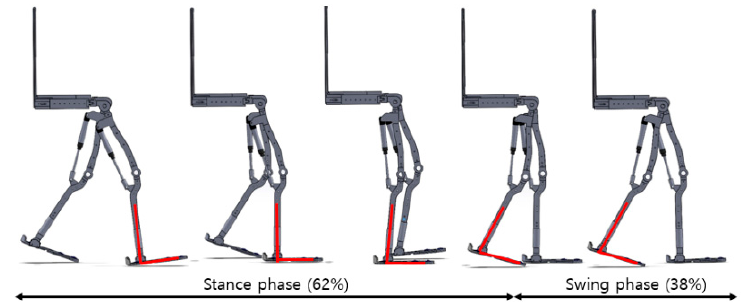
Figure 2. Stance and swing phases in the gait cycle.